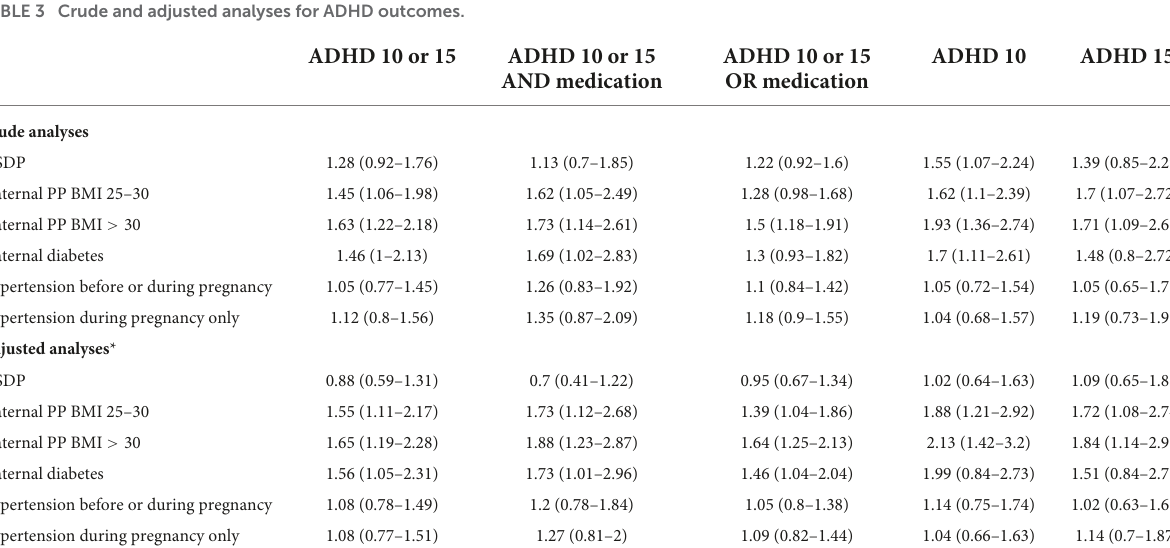
TABLE 3 Crude and adjusted analyses for ADHD outcomes.